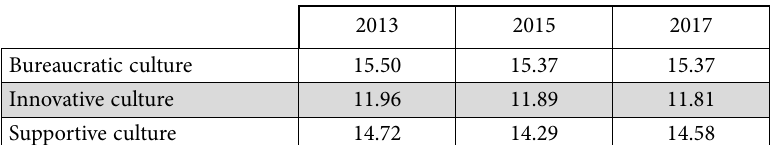
Table 3. Organizational culture index according to Wallach − in 2013, 2015 and 2017 (source: Prepared by the authors)